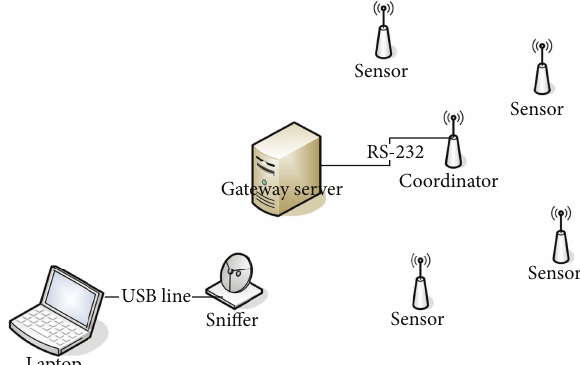
Figure 5: Experimental network structure.